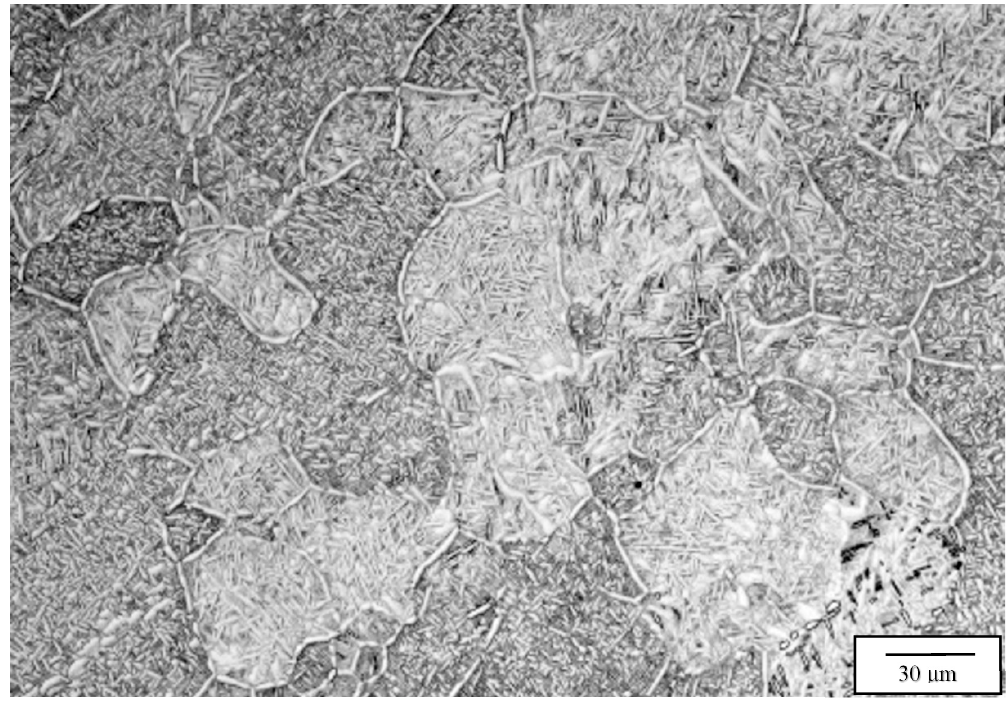
Figure 6. Variant 3 image for the Arcam Q20 top section, X plane.